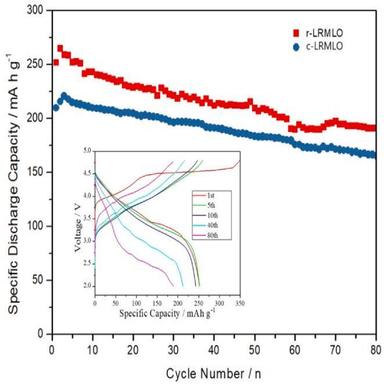
Charge-discharge cyclic performances of r-LRMLO (a) and c-LRMLO (b) electrodes.